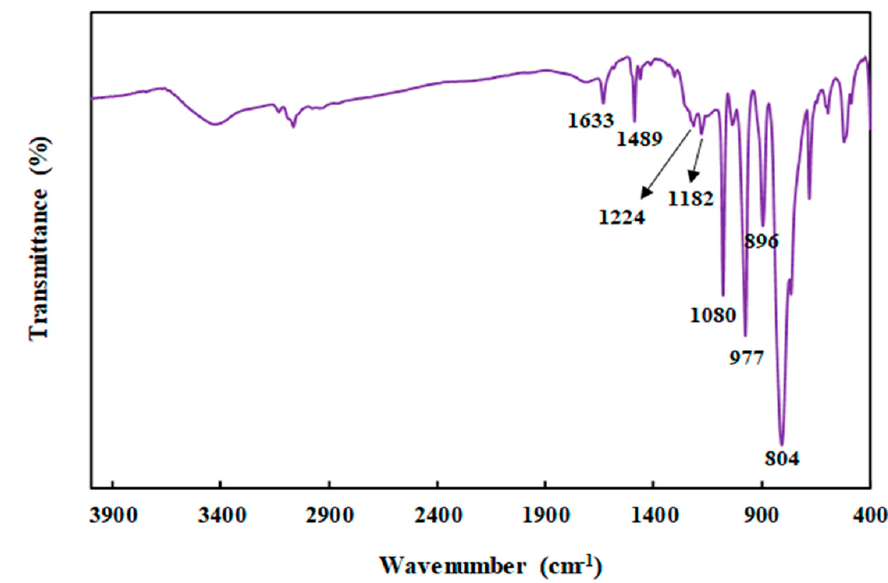
Figure 1. FTIR spectrum of [PyPS] 3 PW 12 O 40 catalyst .